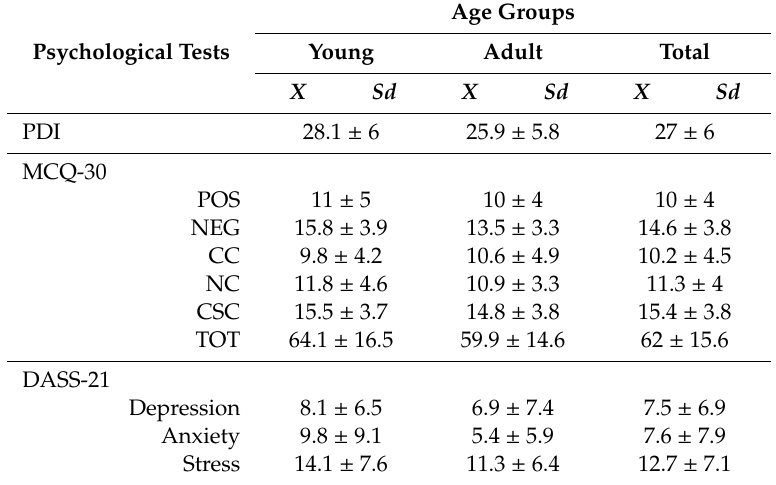
Table 2. The mean (and standard deviations) of the raw scores performed in the psychological tests. Age Groups Young Psychological Tests